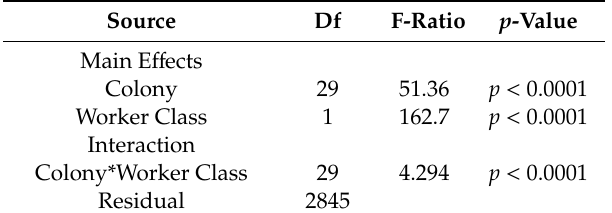
Table 1. Results of the two-way ANOVA for Lasius niger worker size. “Head width” was used as the dependent variable while “colony” and “worker class” were the independent variables (factors). The interactions among the factors is also presented.